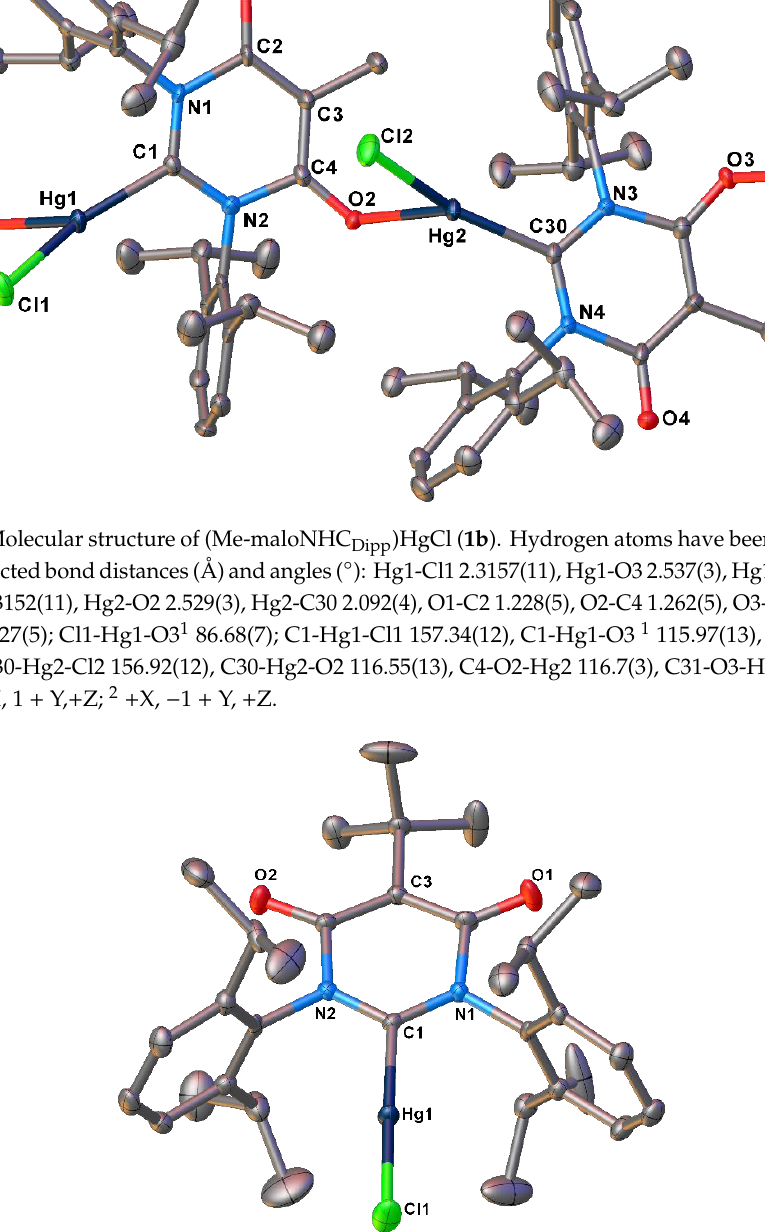
Figure 3. Molecular structure of ( t -Bu-maloNHC Dipp )HgCl ( 2b ). The second molecule in the asymmetric unit and hydrogen atoms have been omitted for clarity. Selected bond distances (Å) and angles ( ◦ ): Molecule 1, Hg1-Cl1 2.2558(15), Hg1-C1 2.056(5), O1-C4 1.221(7), O2-C2 1.232(7); C1-Hg1-Cl1 177.50(15); Molecule 2 (not shown), Hg2-Cl2 2.235(2), Hg2-C33 2.062(5), O3-C34 1.229(7), O4-C36 1.220(7), C33-Hg2-Cl2 177.74(15).